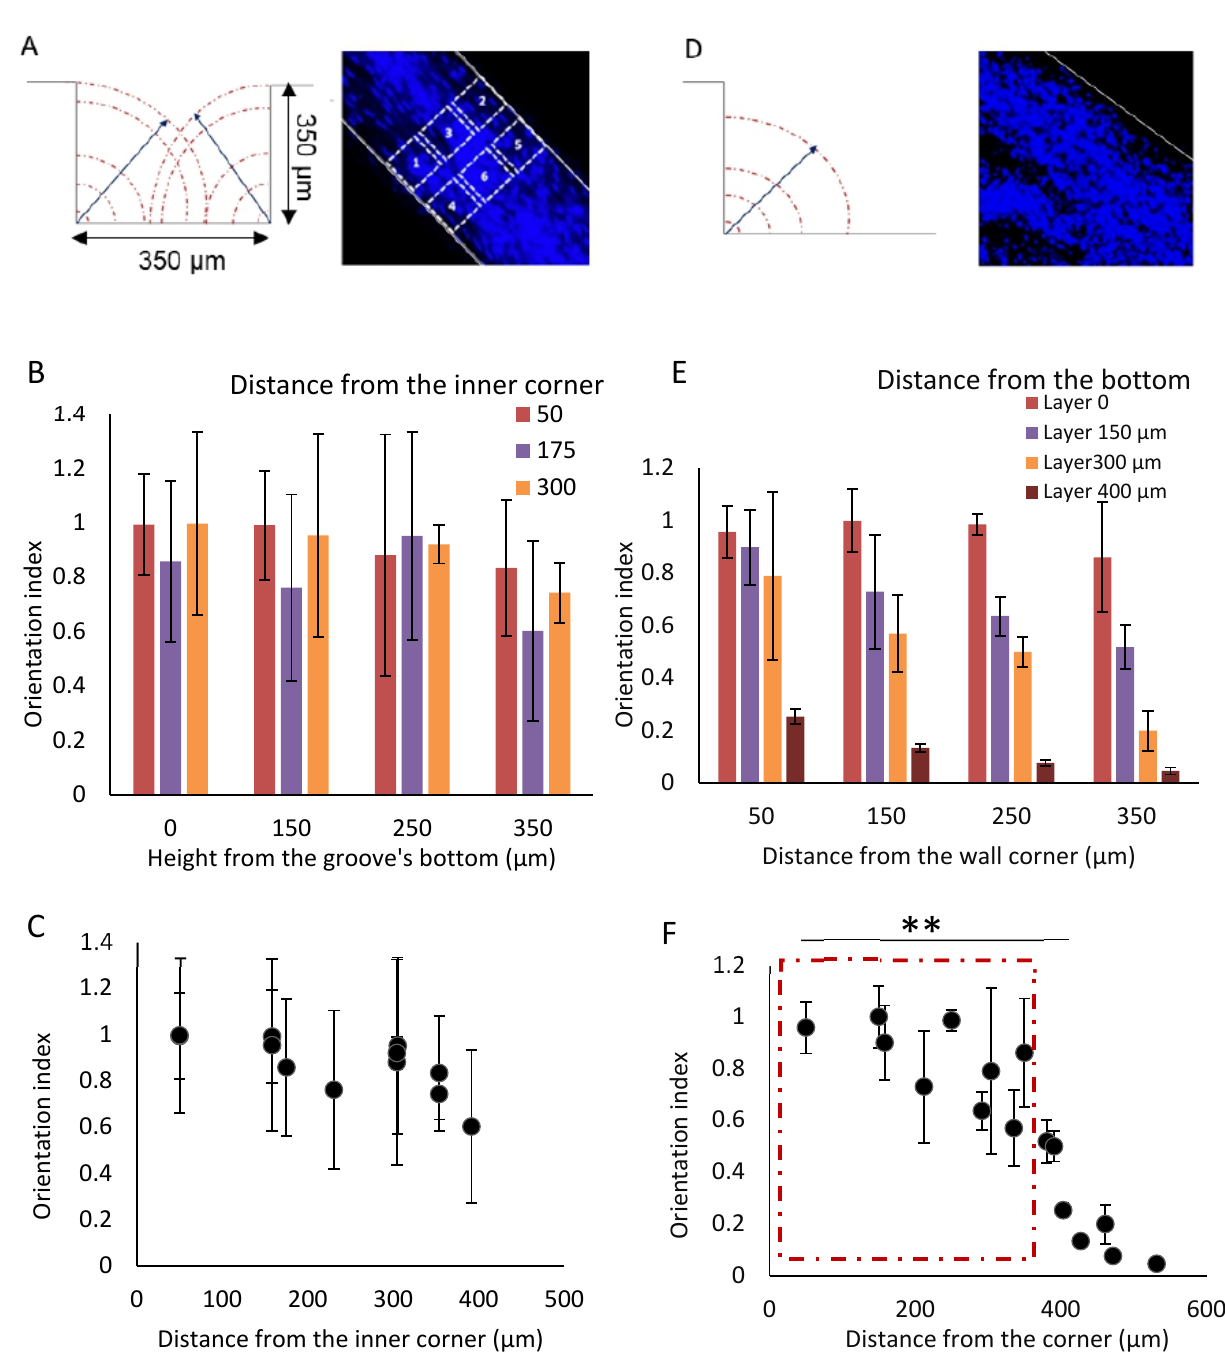
Figure 3. The calculation of the distance of alignment. ( A ) the contact guidance of the corners to improve the cell alignment in a groove. The region of interest (ROI) in a stack of confocal image for measuring the alignment in the cells. Measurements are repeated for several heights. ROI area 100 × 100 µ m. Positions: 1 and 2 = near the wall, 3 = center of the groove, 4, 5 and 6 = repeat of analysis in proximal position in the groove. ( B ) the measurement of cell alignment in relation to the distance from the groove’s corner in a groove with 350 µ m by 350 µ m dimensions. The cell alignment in different height from the bottom of the groove. Two-way ANOVA shows no significant difference in the alignment. ( C ) the orientation index in different distance from the inner corner of the groove. Maximum distance from the corner in this case is 391 μ m. ( D ) the contact guidance of the corner in a groove with infinite width. The middle confocal stack of H9c2 cells in co ‐ culture with fibroblasts in 3D dECM ‐ fibrin hydrogel, DAPI staining. The cells are restricted on one side. The height of the groove is 350 μ m and the width is 2 mm which can be considered as infinite. ( E ) the measurement